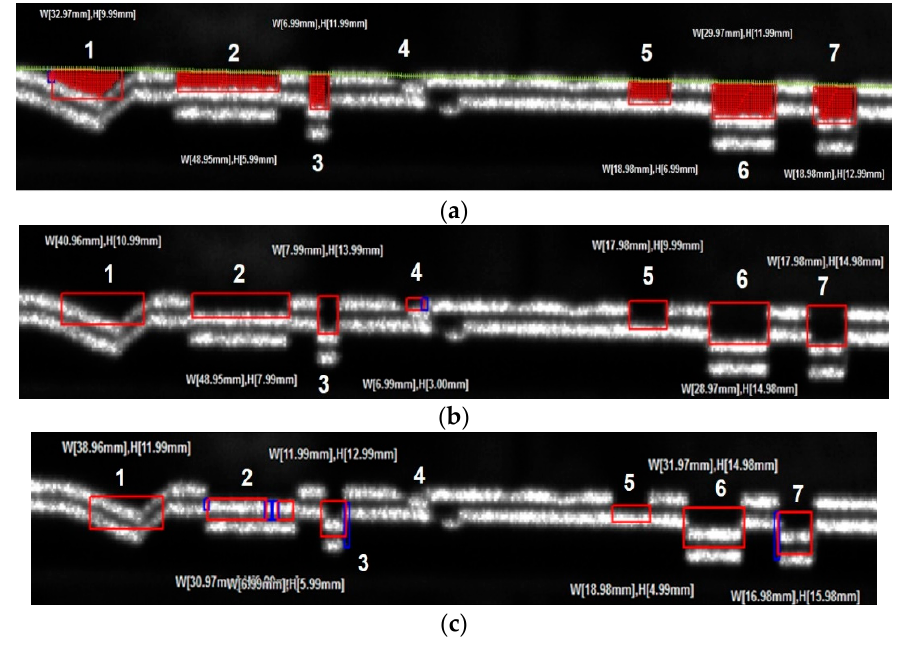
Figure 15. Wear measurement results for the contact strip using the ( a ) first top fitted line, ( b ) second top fitted line, and ( c ) bottom fitted